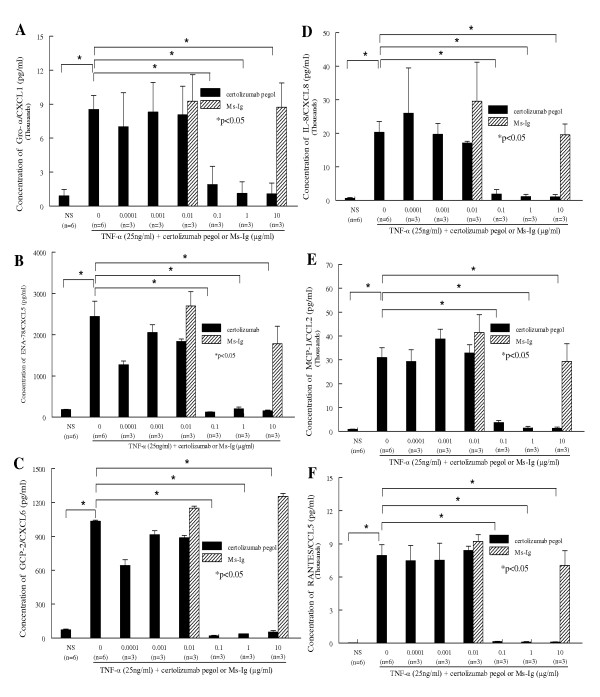
Certolizumab pegol inhibits TNFα-stimulated human dermal microvascular endothelial cell angiogenic chemokine secretion. ELISAs were performed to determine the concentrations of angiogenic chemokines in 24-hour TNFα (25 ng/ml)-stimulated culture supernatants. Certolizumab pegol or mouse-IgG (Ms-Ig) control were added to the cultures along with TNFα stimulation. Concentrations of representative samples show that human dermal microvascular endothelial cell (HMVEC) secreted chemokines are significantly upregulated by TNFα (*P < 0.05) and downregulated by certolizumab pegol in a concentration-dependent manner (*P < 0.05). (A) Growth-related oncogene alpha (Gro-α)/CXCL1, (B) epithelial neutrophil-activating peptide-78 (ENA-78)/CXCL5, (C) granulocyte chemotactic protein-2 (GCP-2)/CXCL6, (D) IL-8/CXCL8, (E) monocyte chemoattractant protein-1 (MCP-1)/CCL2, and (F) regulated upon activation normal T-cell expressed and secreted (RANTES)/CCL5. For each set of experiments, means of the concentration of each chemokine are given ± standard error of the mean.